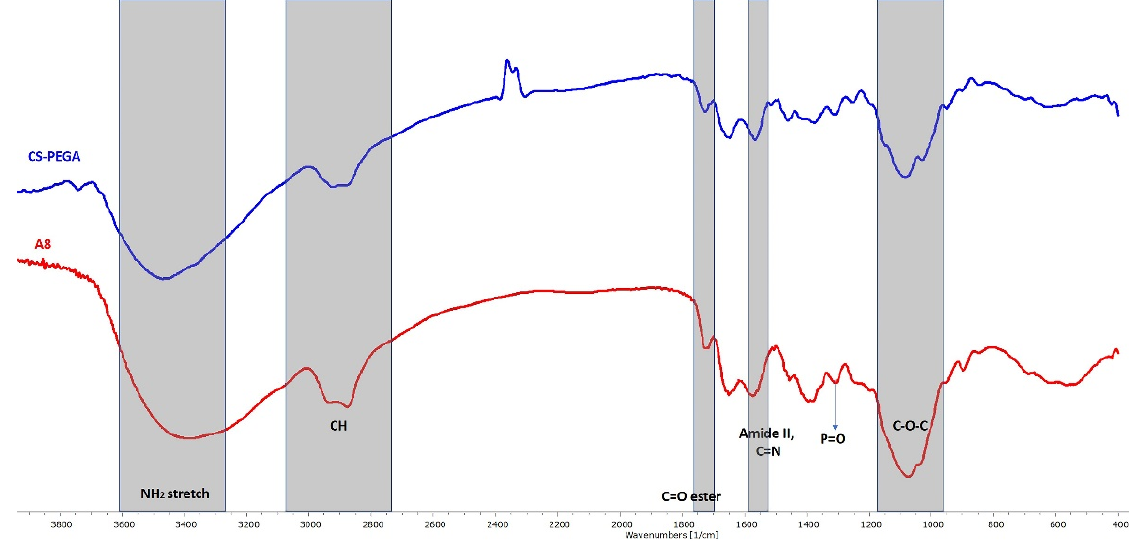
Figure 3. FTIR spectra of the modified chitosan (CS-PEGA) and chitosan particulate hydrogels (A8 sample).